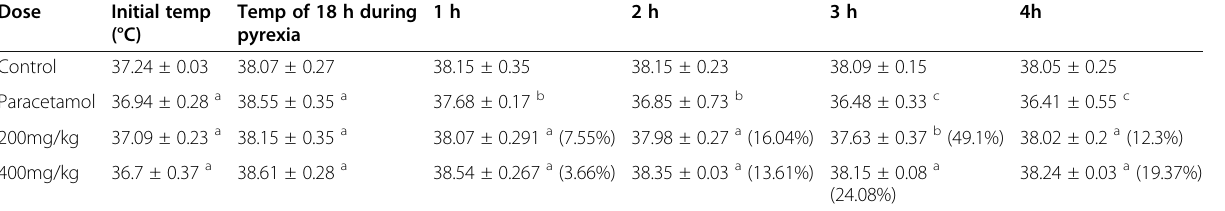
Table 2 Antipyretic activity of methanol leaves extract of A . auriculiformis (MEAA) and standard drug